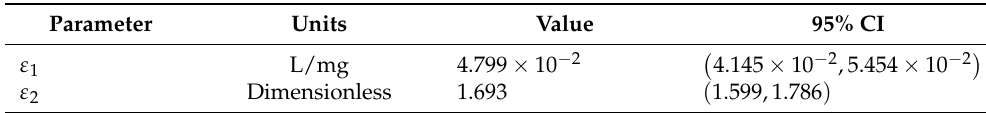
Figure 1. Chlorambucil cytotoxicity rate ( µ AC ) to leukemia cancer cells. The solid green line repre- sents the experimental data obtained from Guzev et al. and the red ‘ × ’ marker is the estimated value given by Equation (8). Table 3. Parameters and 95% CI for the chlorambucil cytotoxicity rate (days − 1 ) of Equation (8) from its concentration in